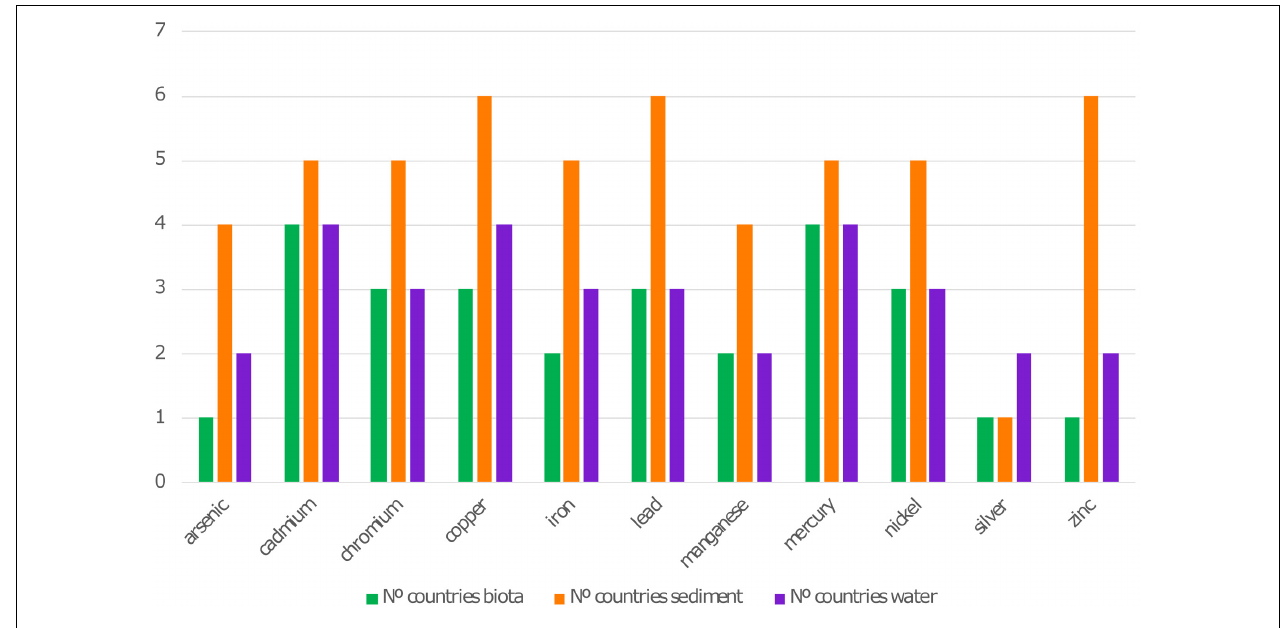
FIGURE 3 | Substances monitored in all three matrices and number of countries providing